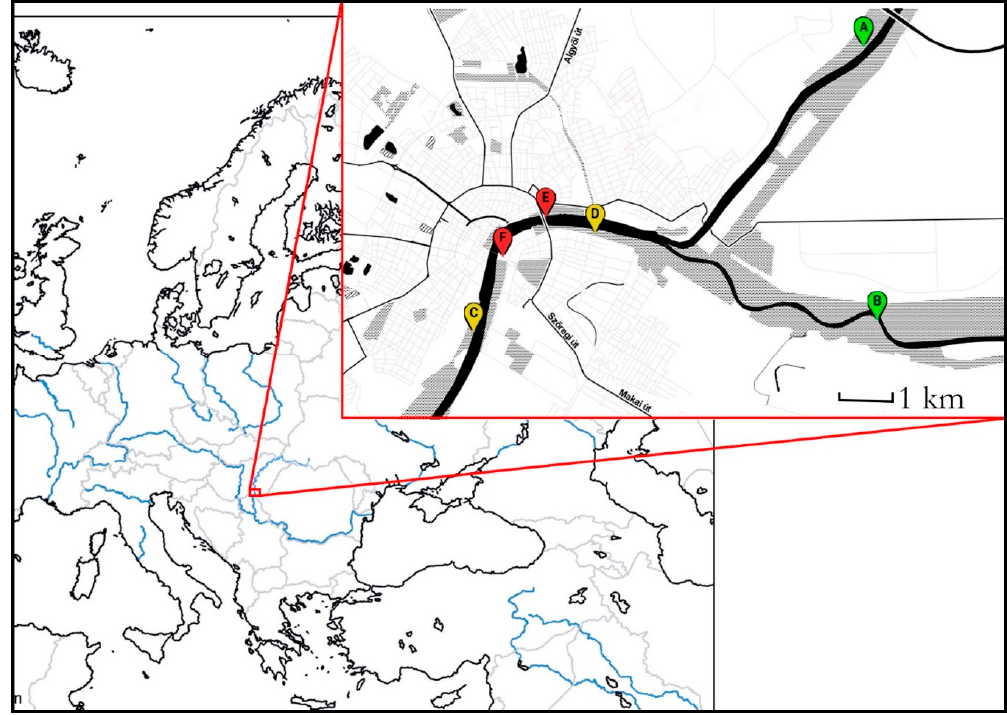
Figure 1. The map of the study sites. A and B rural, C and D suburban, and E and F urban sites. Vegetation originally was a primary forest of white willow ( Salix alba ) and white poplar ( Populus alba ). In the last decades, two invasive tree species [57], green ash ( Fraxinus pennsylvanica ) and box elder ( Acer negundo ) encroached on the area [55]. The undergrowth was dominated by invasive species, with a few natives (Table 1).